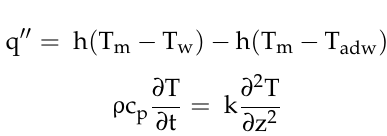
Figure 5. Pressure coefficient via CFD and experiment.